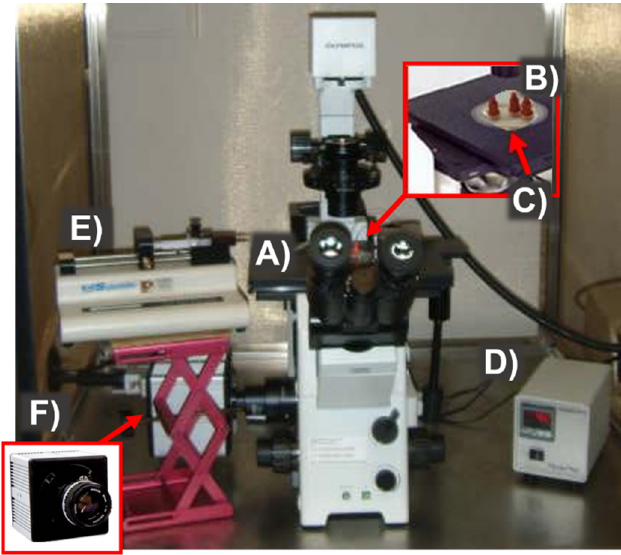
Figure 2. Set-up and instrumentation for experimental procedures. (A) inverted microscope, (B) microfluidic device, (C) thermoplate, (D) thermal device/control, (E) syringe pump, and (F) high- speed camera.